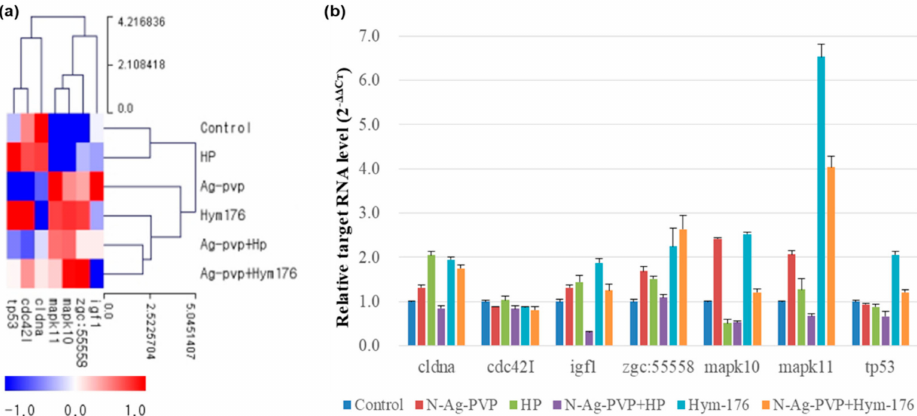
Figure 5. Comparison of expected and measured expression of key genes in zebrafish larvae exposed to N-Ag-PVP, HP, N-Ag-PVP + HP, Hym176, or N-Ag-PVP + Hym176. ( a ) Gene expression level by z-score and ( b ) relative target RNA level (2 − ∆∆ Ct ). The z-score is based on the average of each expressed gene ( ∆ Ct = Target Ct − actb2 Ct, ∆∆ Ct = Target Sample ∆ Ct − control Sample ∆ Ct, 2 − ∆∆ Ct = Normalized gene amount of target group relative to target gene amount of control